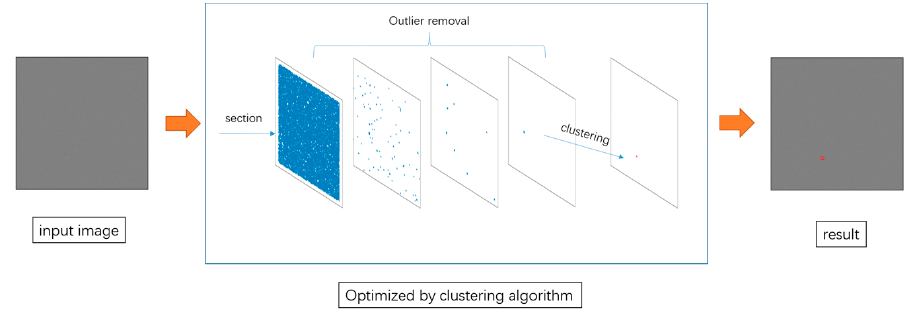
Figure 1. The overall framework of the proposed method.